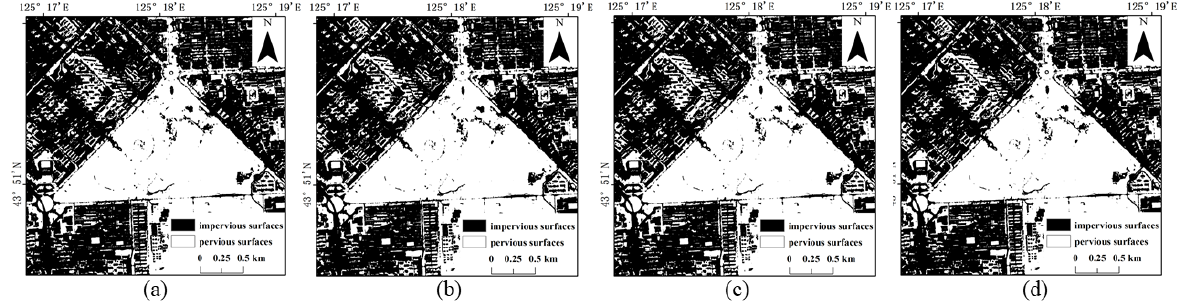
Figure 7. Results of impervious surface extraction with BDA: ( a ) 40,000 samples; ( b ) 60,000 samples; ( c ) 80,000 samples; ( d ) 100,000 samples.